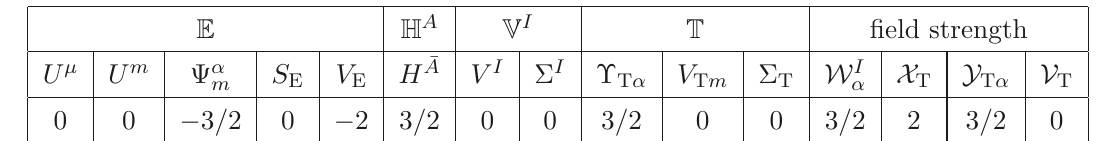
= 1 superfields. The index ¯ A runs from 1 to 2 n H . N